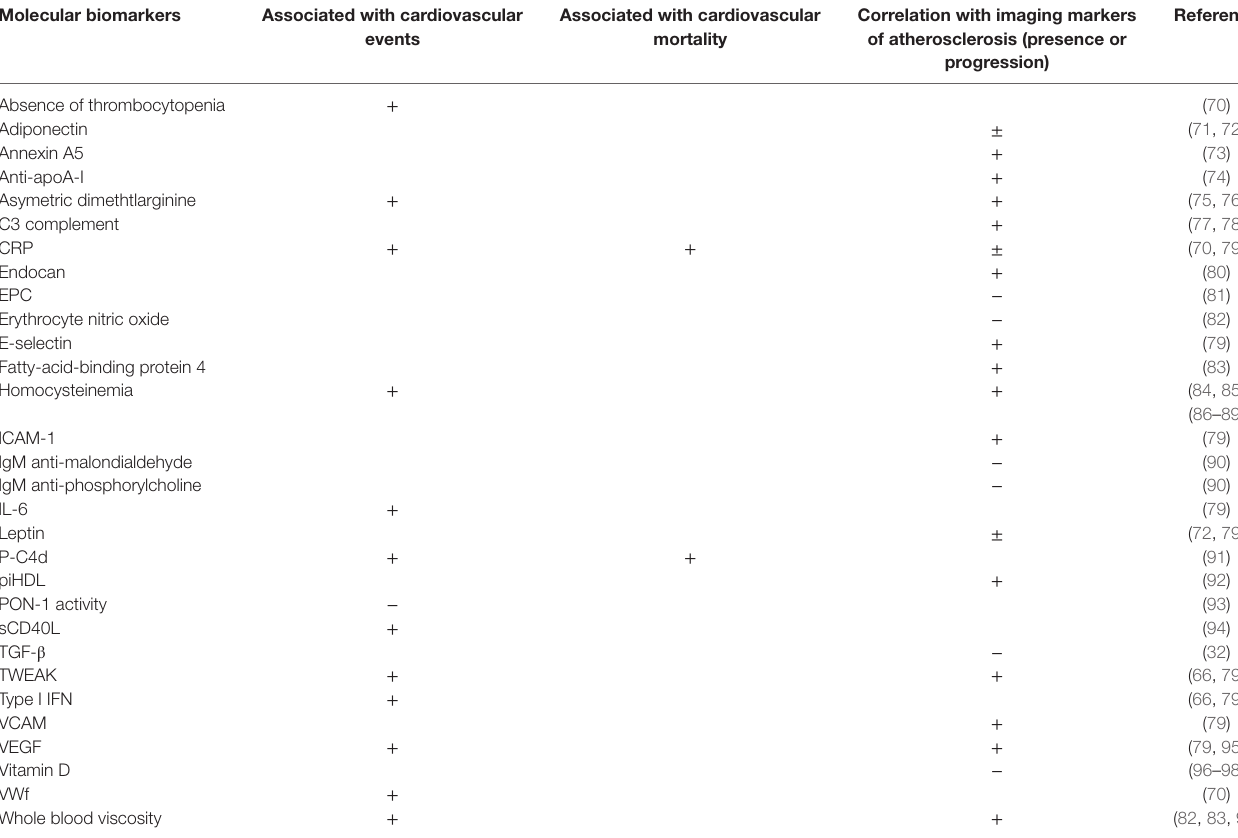
TABLe 1 | Molecular biomarkers and associations with cardiovascular events and mortality and atherosclerosis imaging surrogates. Molecular